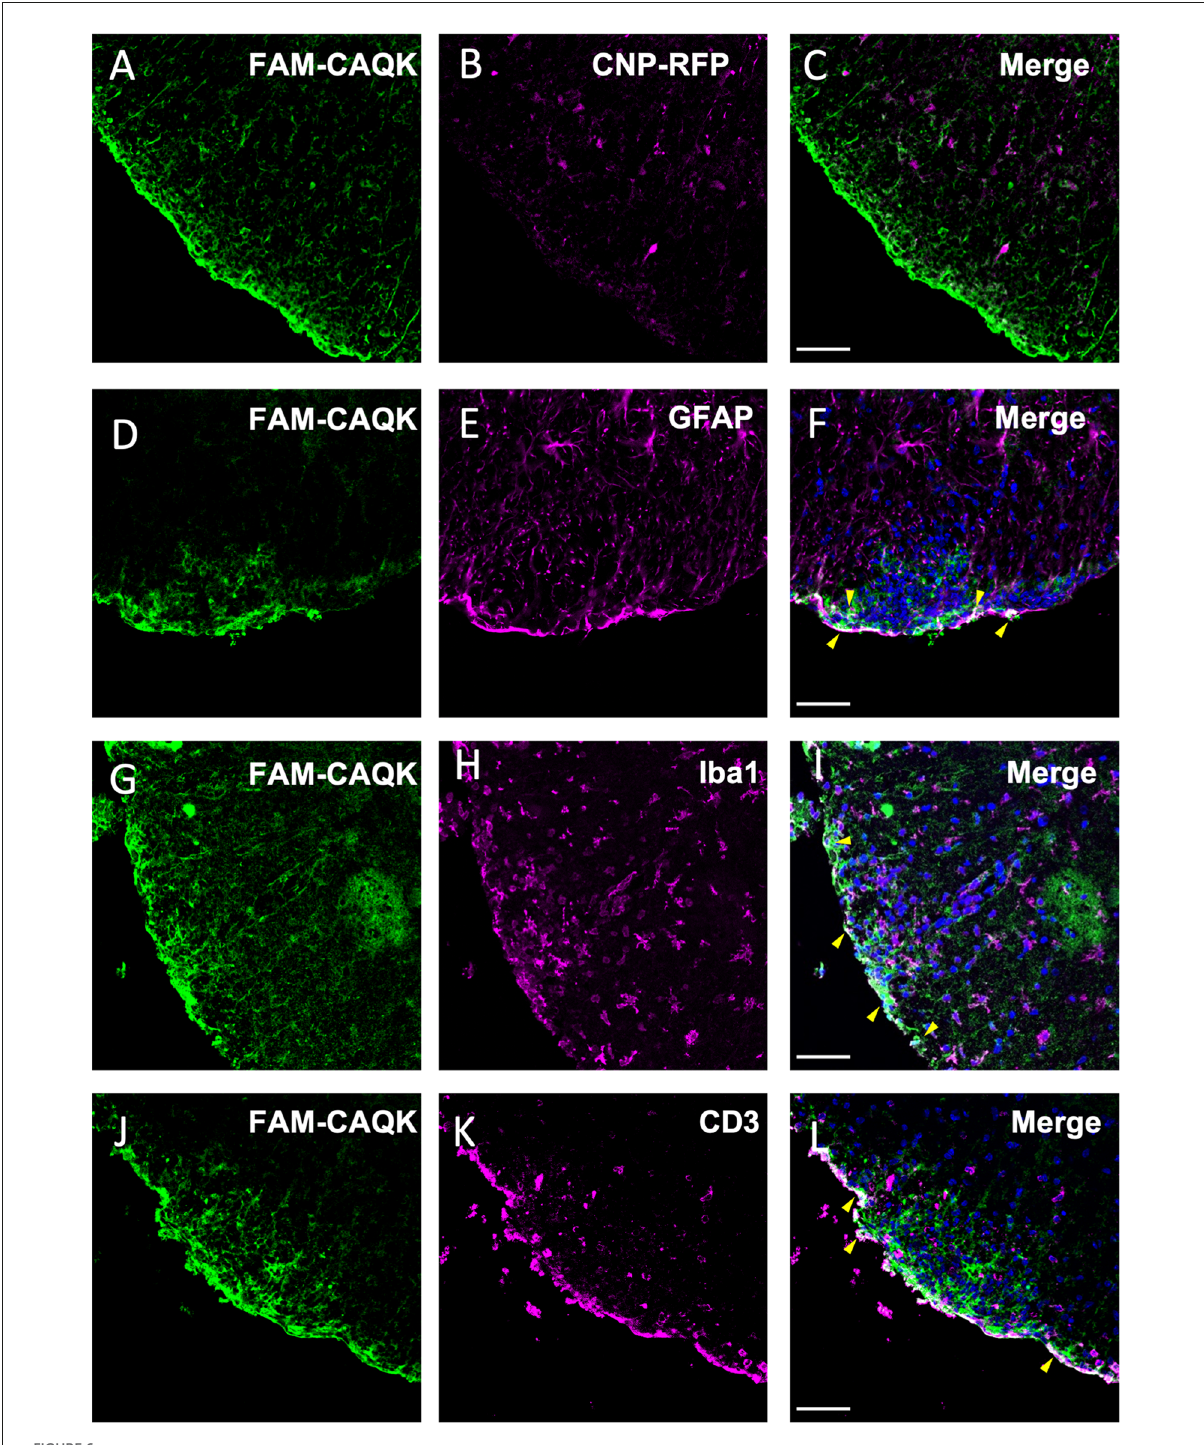
FIGURE6 Association of CAQK with invading immune cells and reactive astrocytes at lesions in the EAE model. Fluorescent FAM-CAQK (green in A,D,G,J ) homes to lesion sites identified by DAPI + cell clusters (blue in C,F,I,L ) after intravenous application at disease peak. The peptide does not associate with oligodendrocytes ( B , magenta) genetically labeled in CNP1-Cre;Rosa26-tdTomato transgenic mice. Merged images in (C) . At the gross level, CAQK peptide associates with cells characterizing lesion sites, including reactive astrocytes (GFAP, E , magenta), microglia (Iba1, H , magenta) and infiltrating immune cells (CD3, K , magenta). Merged images are shown in (C,F,I,L) , and overlaps indicated in white color are pointed out with yellow arrowheads in (F,I,L) . Scale bars: 75 µ